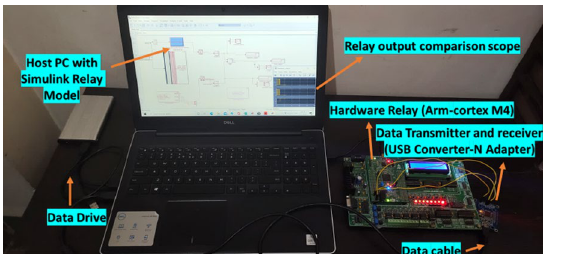
Fig. 11 HIL test setup to test the proposed algorithm